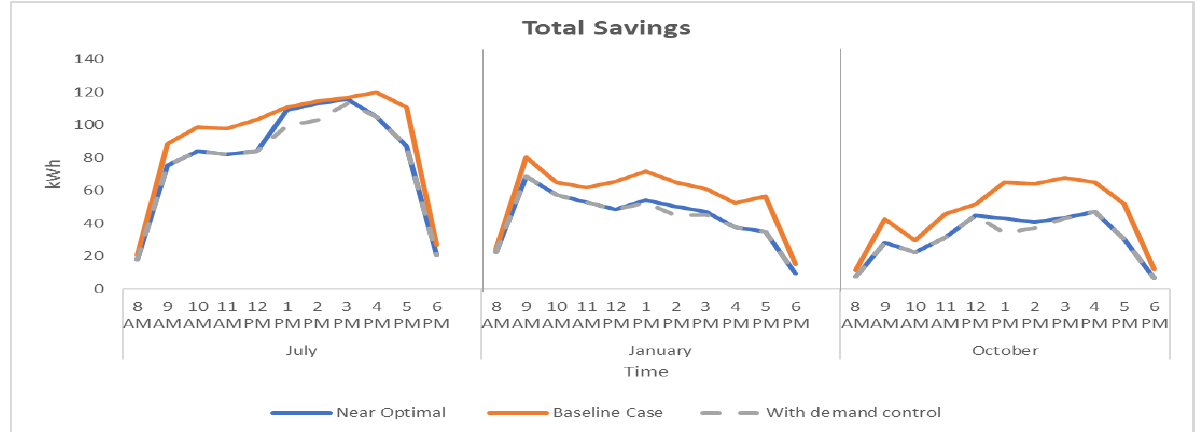
Figure 17. The total system savings for each day being